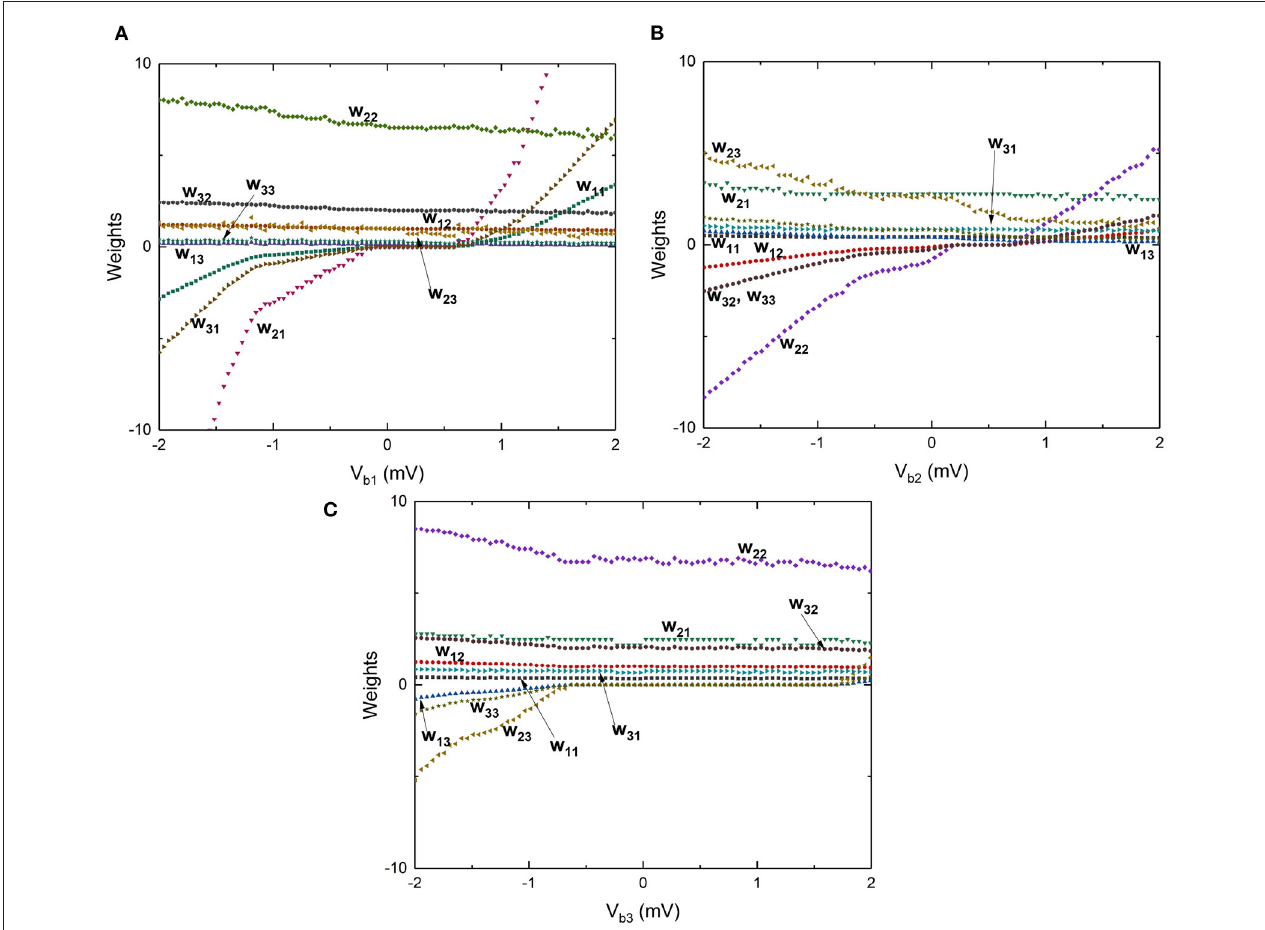
FIGURE 15 | Large scale simulations performed by varying the bias voltages between -2 and 2 mV and measuring the weights in the matrix associated with the 3 × 3 network shown in Figure 12 . (A) Weights vs. bias voltage V b1 with voltages V b2 and V b3 constant. (B) Weights vs. bias voltage V b2 with voltages V b1 and V b3 constant. (C) Weights vs. bias voltage V b3 with voltages V b1 and V b2